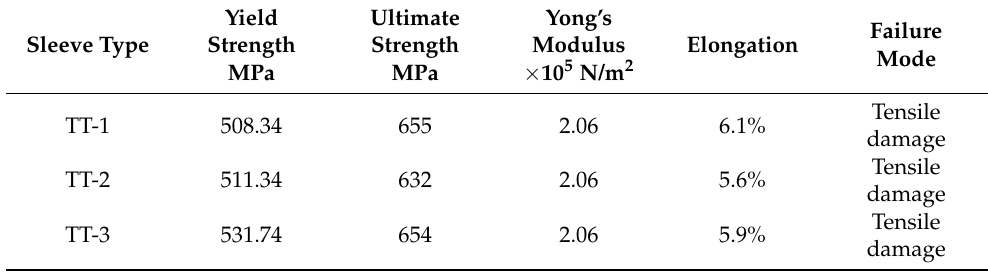
Table 3. The properties of semi-grouted sleeves.